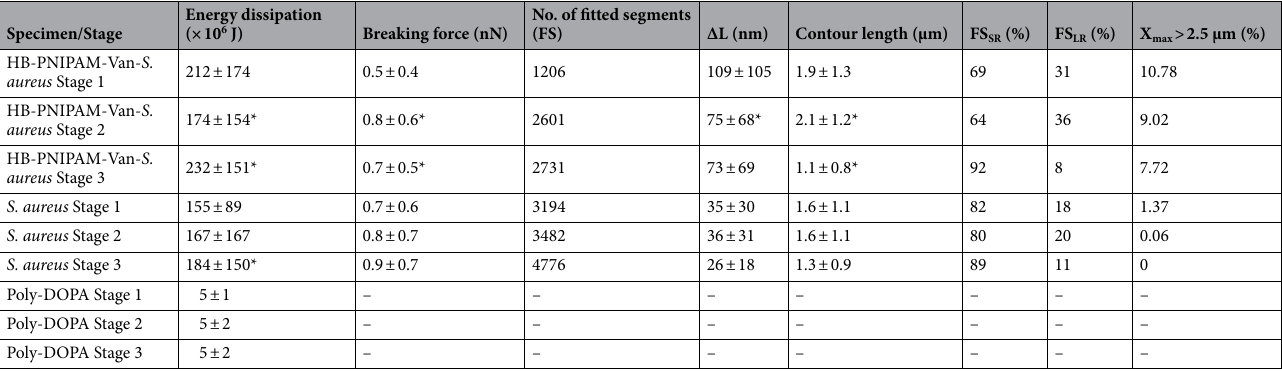
Table 1. Showing the unbinding mechanical properties of HB-PNIPAM-Van- S. aureus , S. aureus and poly- DOPA functionalised probes during removal from the corneal surface using AFM. * p <